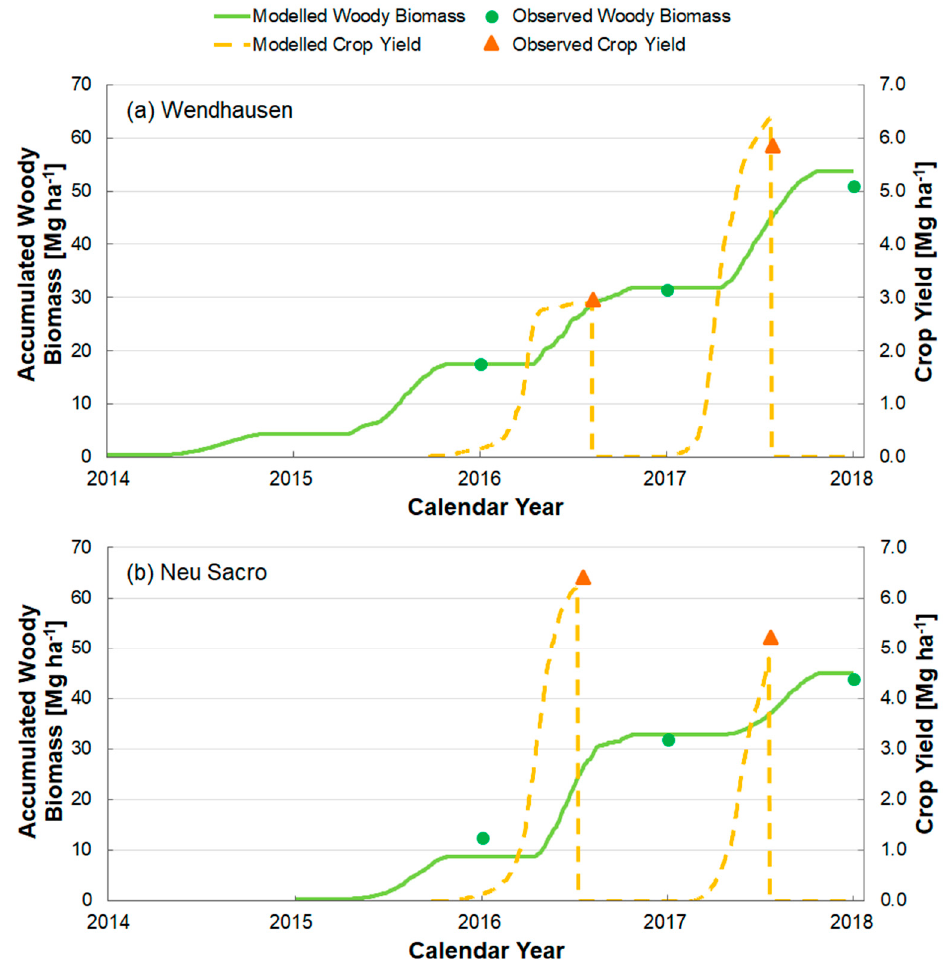
Figure 4. Above-ground tree woody biomass and crop yields accumulated at Wendhausen ( a ) and Neu Sacro ( b ) over the investigated period, as simulated with the Yield-SAFE model (lines) and as observed for the trees (circles) and crops (triangles; winter rapeseed and winter wheat in 2016 and 2017 respectively at Wendhausen; winter wheat and winter barley in 2016 and 2017, respectively at Neu Sacro).